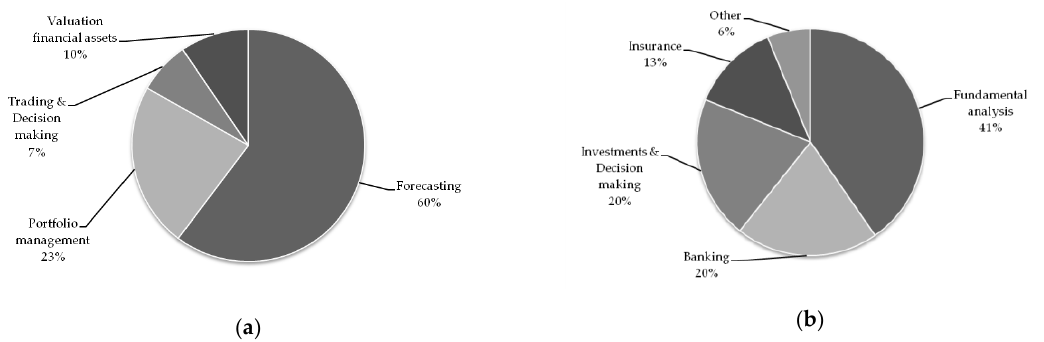
Figure 4. Categorization of the main topics usually analysed when applying fuzzy logic in finance: ( a ) Category of financial markets, and ( b ) category of corporate finance.